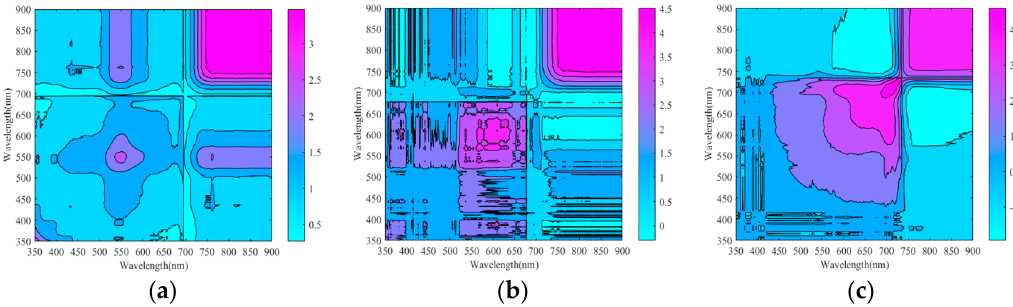
Figure 3. Contour map of synchronous traditional 2D correlation spectra at 350 nm–900 nm: ( a ) Jointing stage, ( b ) heading stage, and ( c ) grain-filling stage.